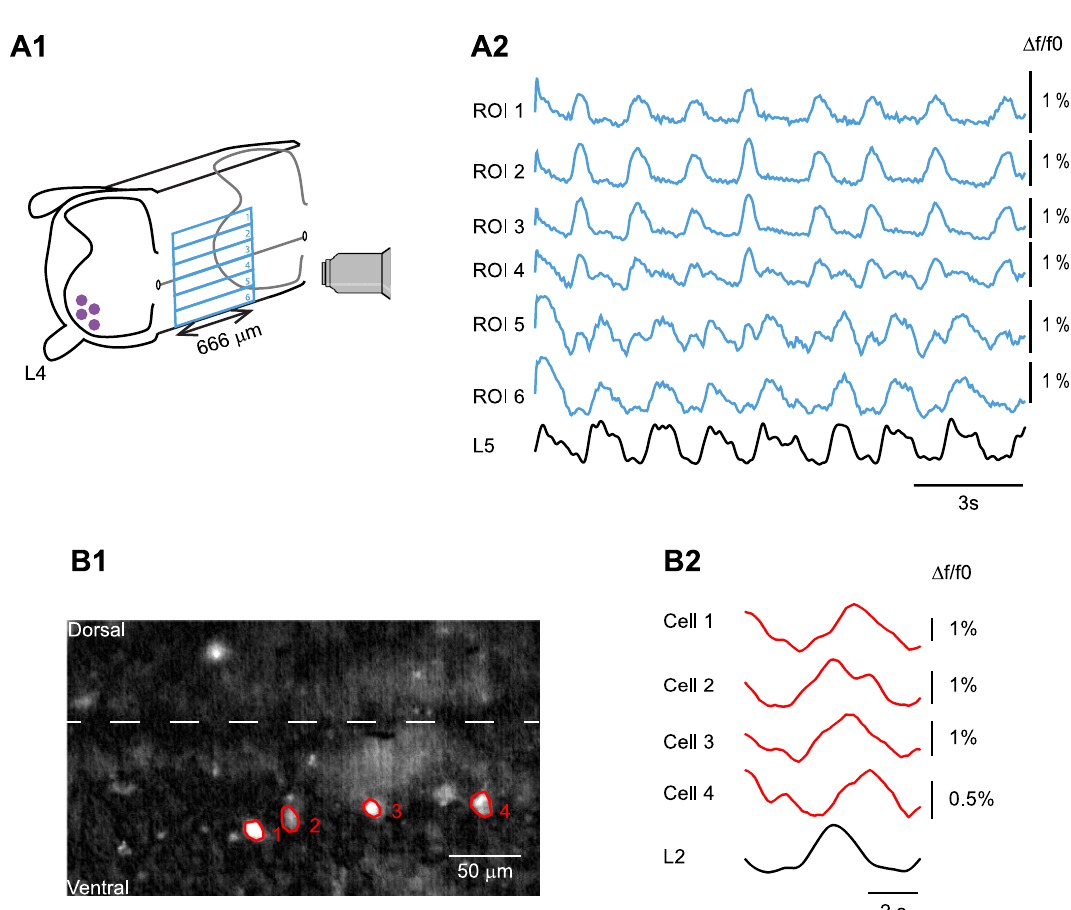
Fig 8. V1 interneurons are rhythmically active in hemisected spinal cords. (A1) Schematic of the experimental setup. Drawing of an En1 -GCaMP6f hemisected spinal cord (in which V1 interneurons express the calcium indicator GCaMP6f) showing the lumbar L4 and rostral segments with the ventral side down. The filled purple circles represent motoneurons. The outer blue rectangle indicates the field of view of the 20 × objective. The six smaller blue rectangles are ROIs. (A2) Calcium signals recorded from the six ROIs (blue traces) are shown together with the integrated neurogram of the L5 ventral root during rhythmic activity evoked by 5 μ M NMDA, 10 μ M 5-HT, and 50 μ M DA in an En1 -GCaMP6f hemisected spinal cord. (B1) Image of the cut face of a hemisected cord showing individual En1 -GCaMP6f neurons, at a more restricted field of view from that shown in A1. The dotted line identifies the central canal and ROIs (red) that were placed around four neurons. (B2) Cycle-triggered calcium signals from the four cells identified in B1 (red traces) extracted after subtracting the local neuropil signal (see Methods) are shown together with the cycle-triggered, integrated neurogram of the L2 ventral root during rhythmic activity evoked by 5 μ M NMDA, 10 μ M 5-HT, and 50 μ M dopamine in an En1 - GCaMP6f hemisected spinal cord. The vertical scales on the right of the calcium signals represent the percentage change in fluorescence. 5-HT, 5-hydroxytryptamine; DA, dopamine, En1 , engrailed-1 ; NMDA, N-methyl-D-aspartate; ROI, region of interest.